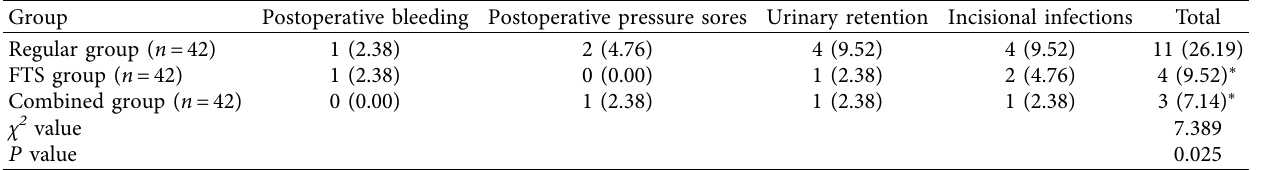
Table 2: Comparison of complications among the three groups ( n , %).